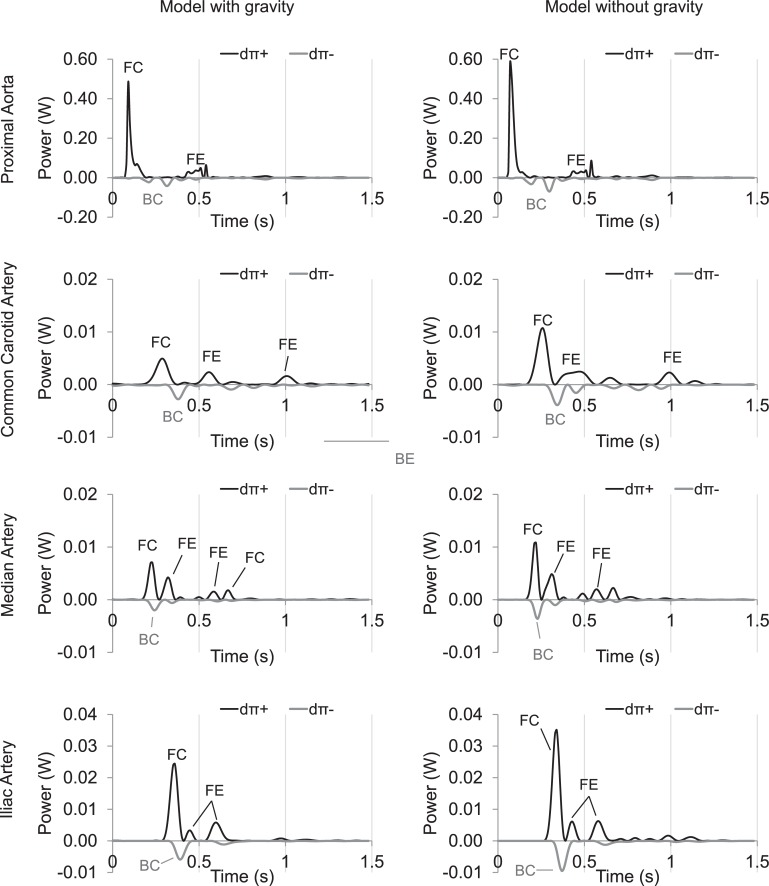
Wave power analysis at several locations of the arterial tree, comparing the model including gravity, with the model neglecting gravity.(FC: forward compression; FE: forward expansion; BC: backward compression; BE: backward expansion; 〖dπ〗_+ and 〖dπ〗_-: forward and backward components of wave power, respectively).